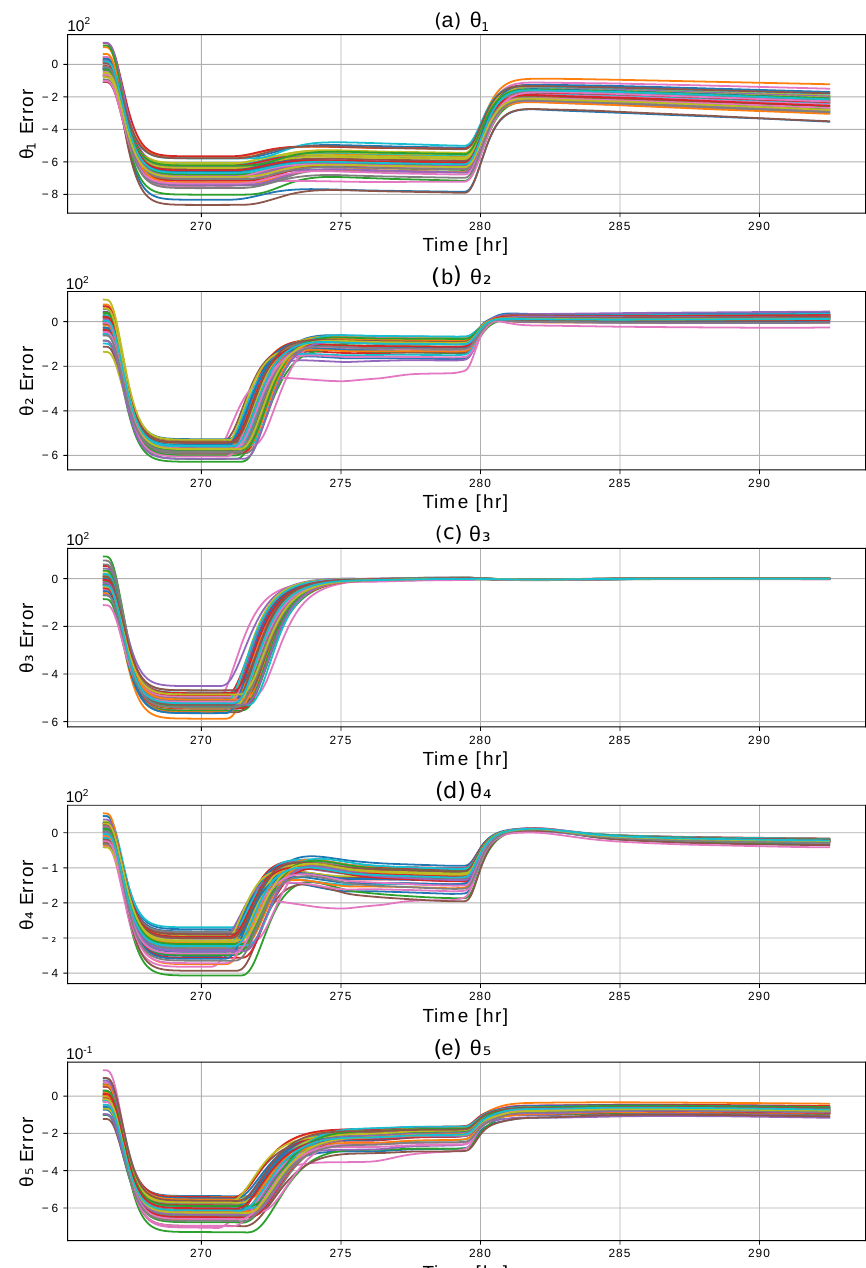
Figure 9. Thermal parameters of the decentralized framework updated via Algorithm 1, (N =